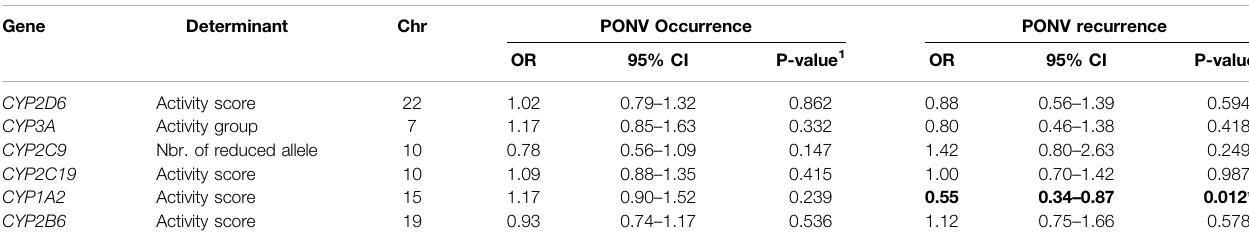
TABLE 4 | Predicted P450 cytochrome activities correlation with PONV¨. Gene